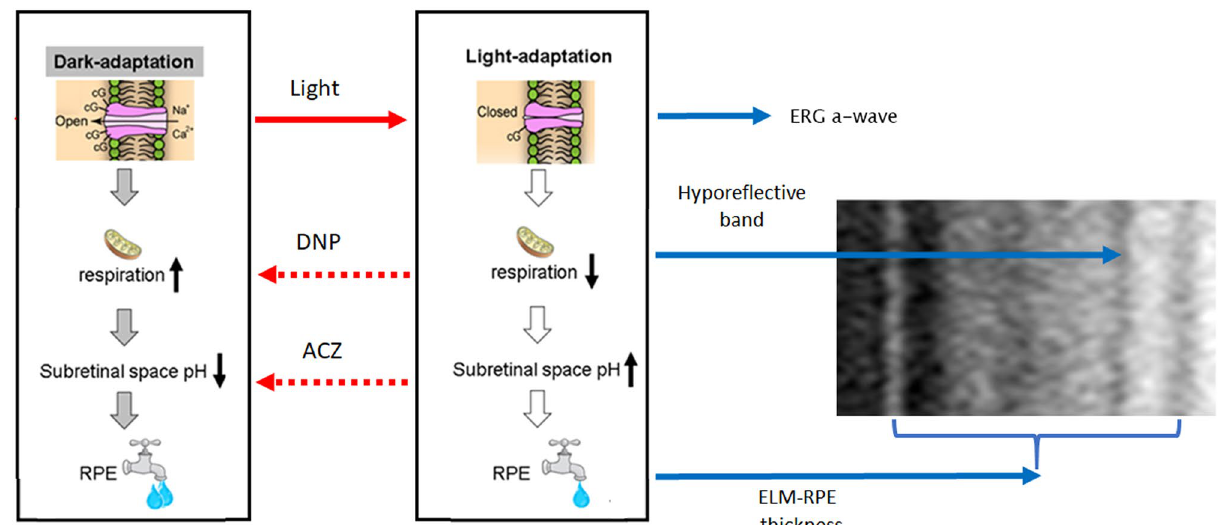
Figure 6. Proposed signaling pathway for two light-induced OCT responses. Adding either DNP or ACZ converted the light phenotype (middle panel) to a dark phenotype (left panel). Our data suggests that DNP activates the upstream mitochondrial signal inducing changes in HB magnitude and ELM-RPE thickness (right panel); ACZ presumed impact on pH was limited to ELM-RPE thickness changes. Based on these observations, we propose that the light–dark HB magnitude change reflects mitochondrial function, whereas the ELM-RPE represents both mitochondrial function and its downstream effect on subretinal space